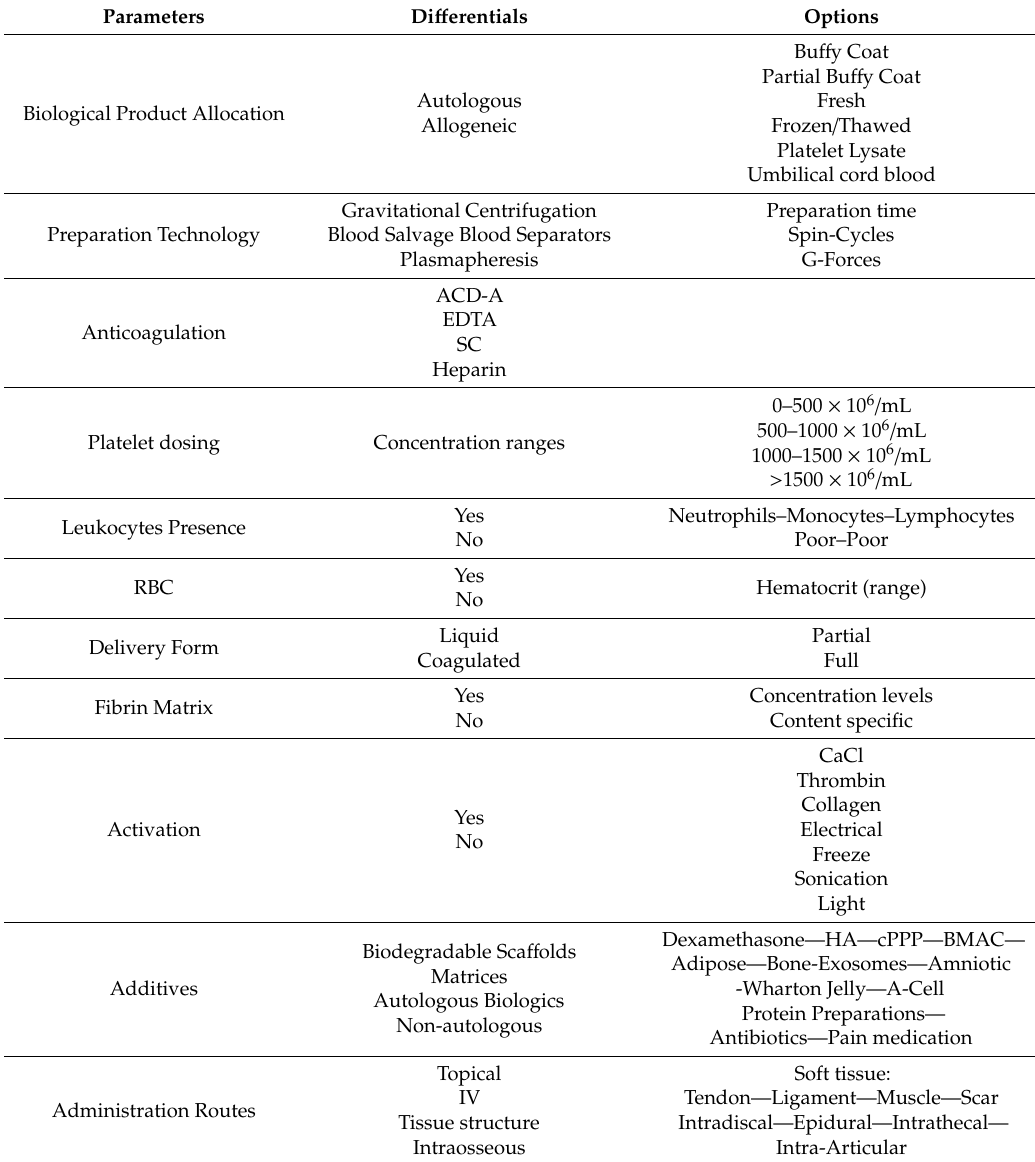
Table 3. Parameters to be considered in developing a PRP classification